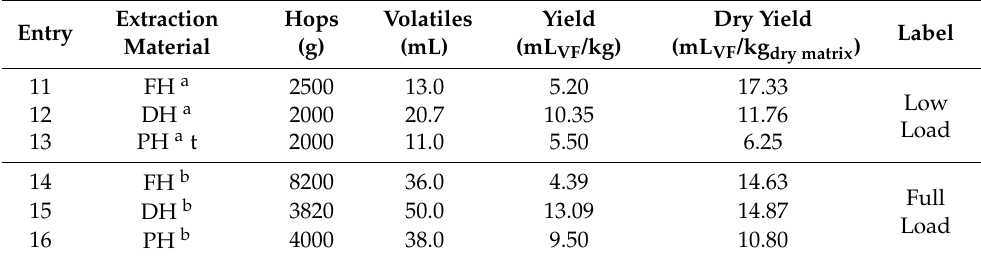
Table 6. MAHD, pilot